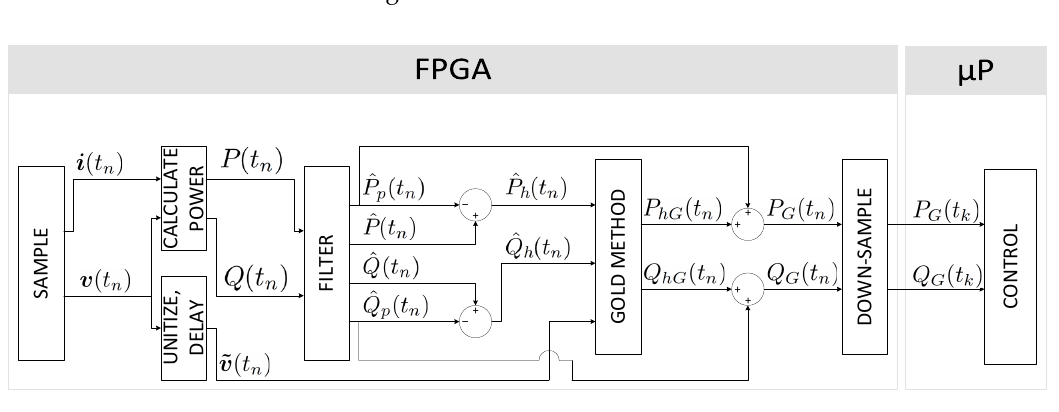
Figure 10. Hardware implementation and signal conditioning for the GOLD method algorithm.